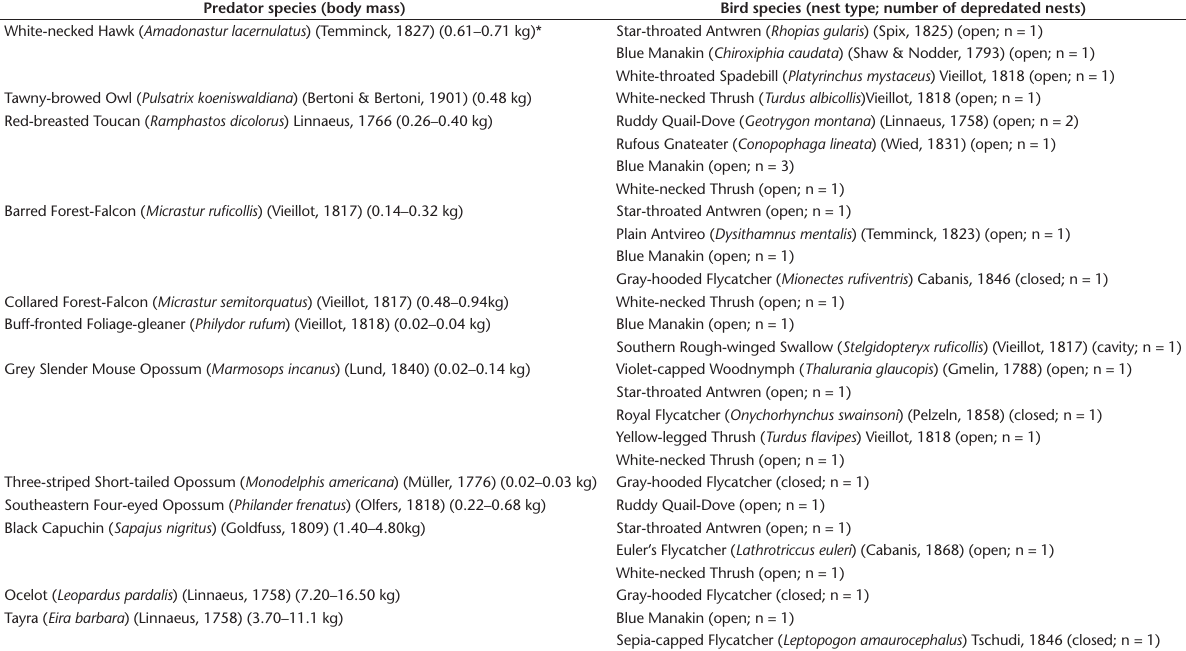
Table 1. Predator species with body mass (kg), bird species, type of nest and numbers of depredated nests detected by camera traps in an area of Brazilian Atlantic